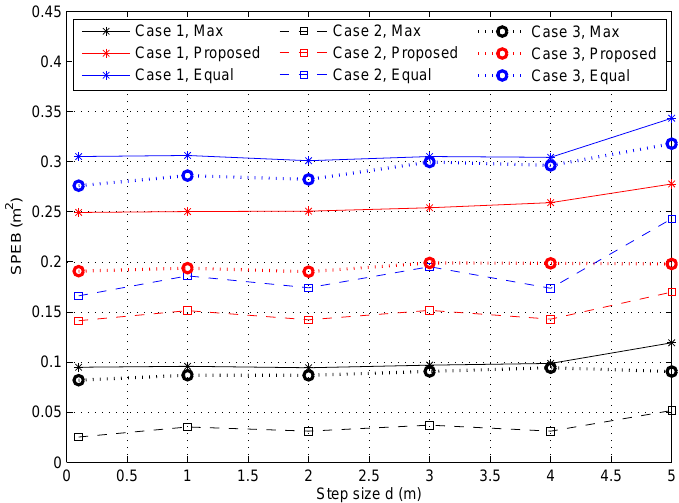
Figure 5. The SPEB of service area with respect to different partition step sizes d